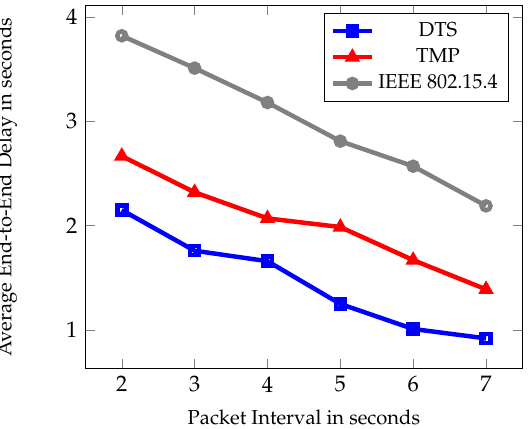
Figure 11. Average end-to-end delay under different packet